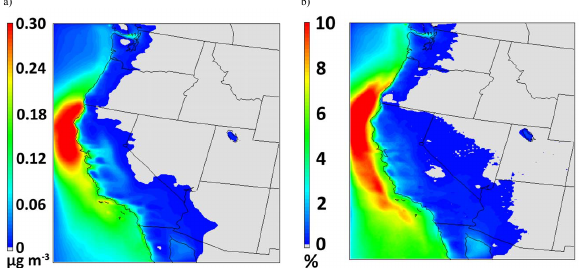
Fig. 4. Average increase (a) and percentage change (b) in surface PM 2 . 5 concentration from marine organics for the bottom-up simu- lation from 1 June to 31 August